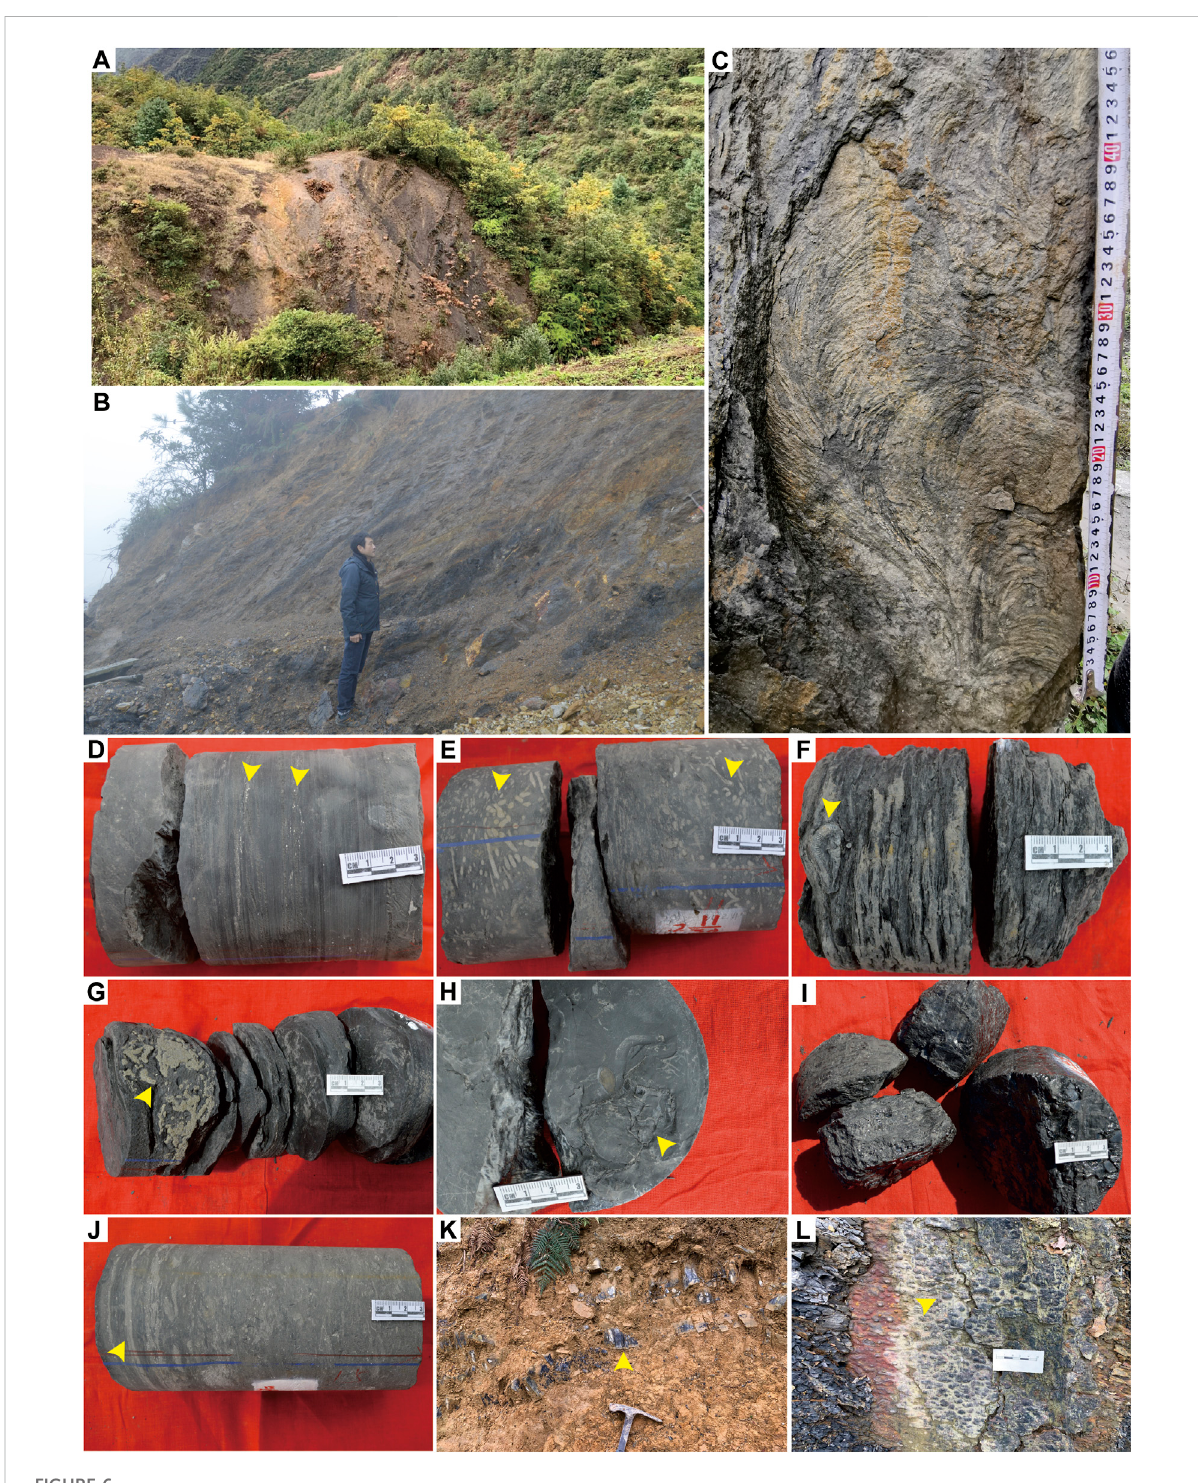
FIGURE 6 Facies association 1. (A) Lithofacies M, section SMK. (B) Lithofacies M, section YGX. (C) Lithofacies Lab (bioturbated arenaceous limestone) with abundant Zoophycos , section LDZ. (D) Lithofacies M, calcareous shale, bioclast interlayer showed directional arrangement (yellow